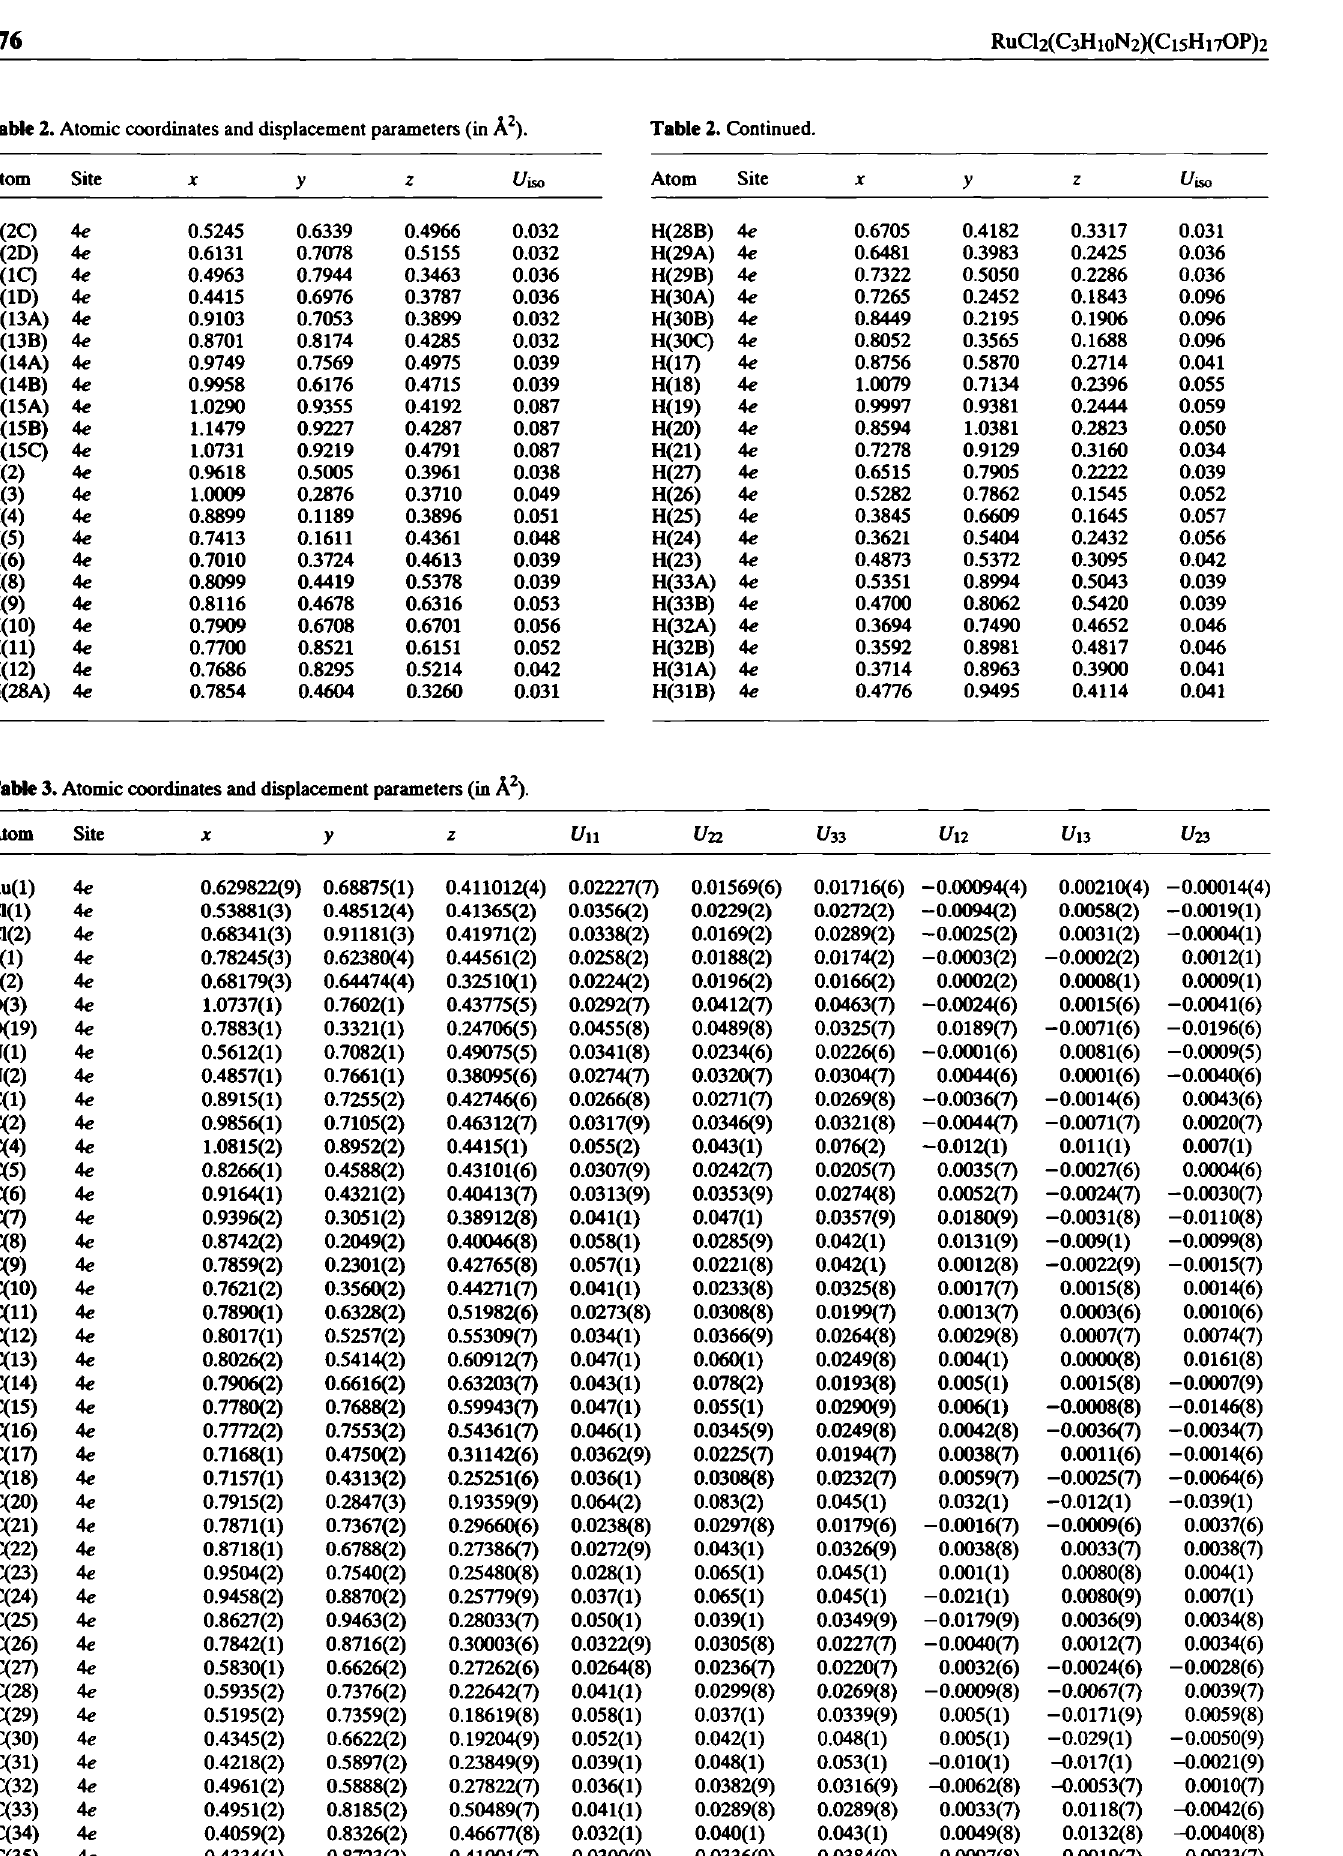
Table 2. Atomic coordinates and displacement parameters (in A 2 ). Table 2. Continued.